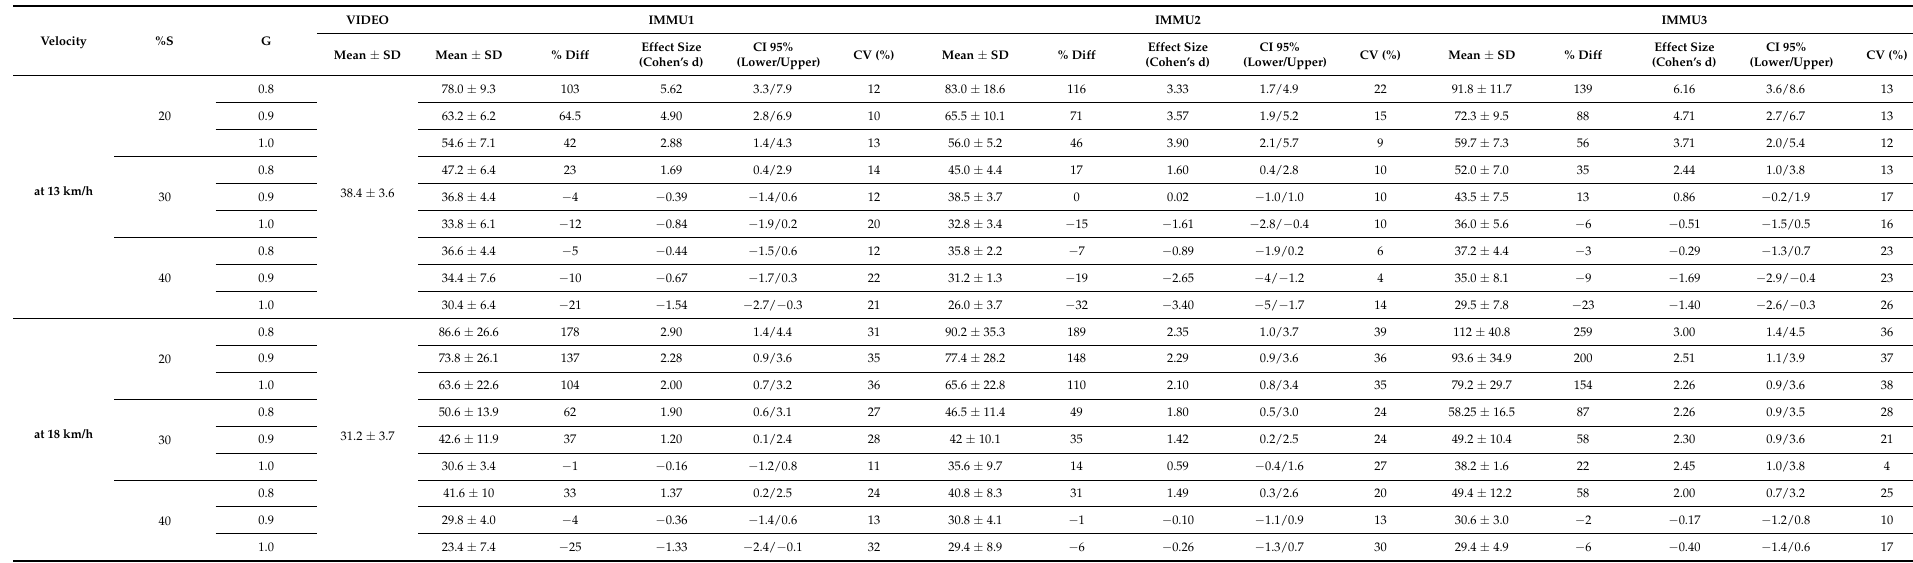
Table 2. Comparison of the smoothing criterion of COD IMMUs devices between COD video criterion measure at 13 km/h and 18